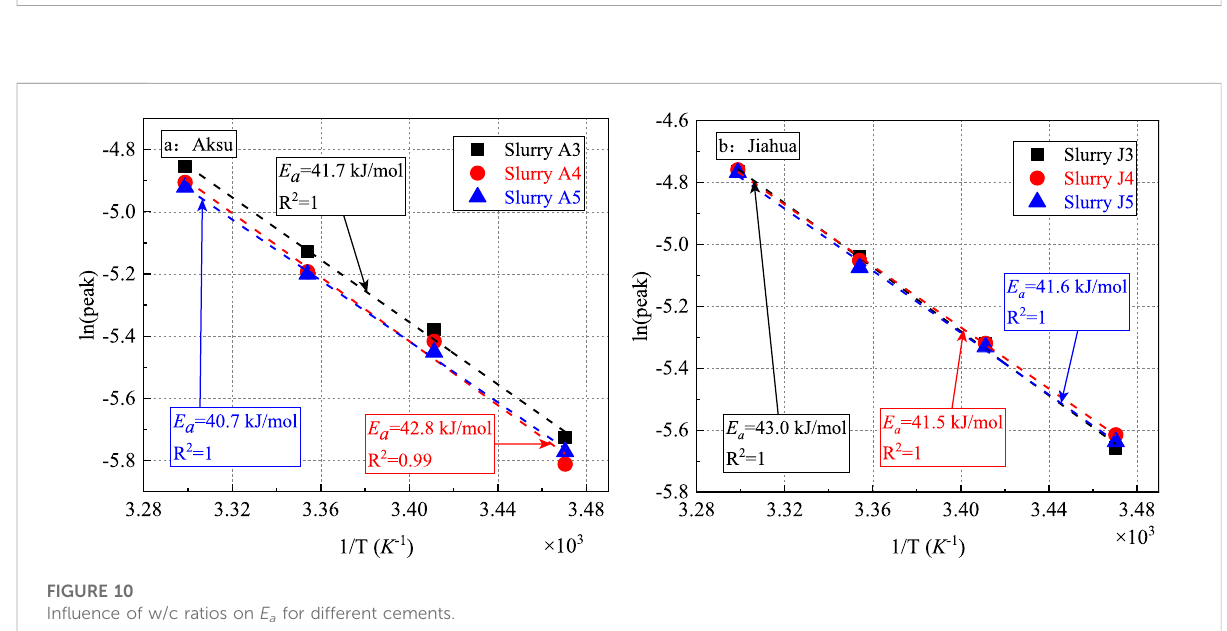
FIGURE 10 In fl uence of w/c ratios on E a for different